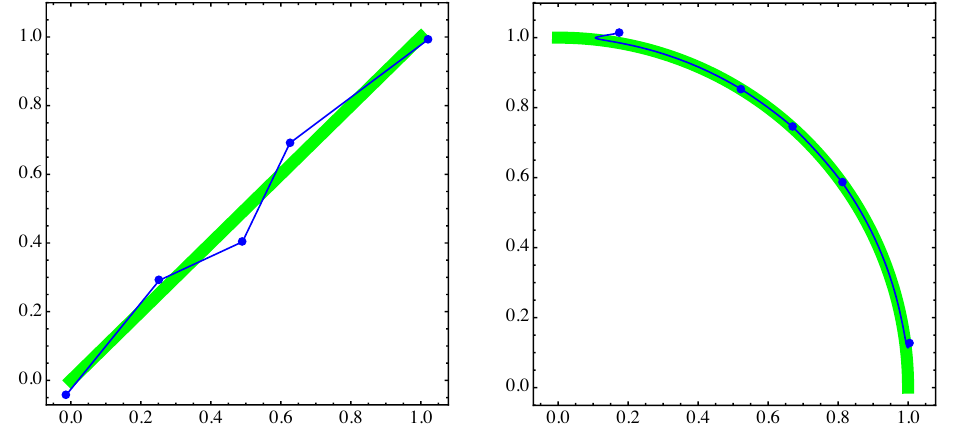
Figure 8. Left: Approximations A (blue dots) and B (blue polygon line) of the Pareto set (green thick line) of MOP (12) for n = 2. Right: corresponding approximations F ( A ) and F ( B ) of the Pareto front, for γ = 1/2. Table 3. Parameter setting for NSGA-II and